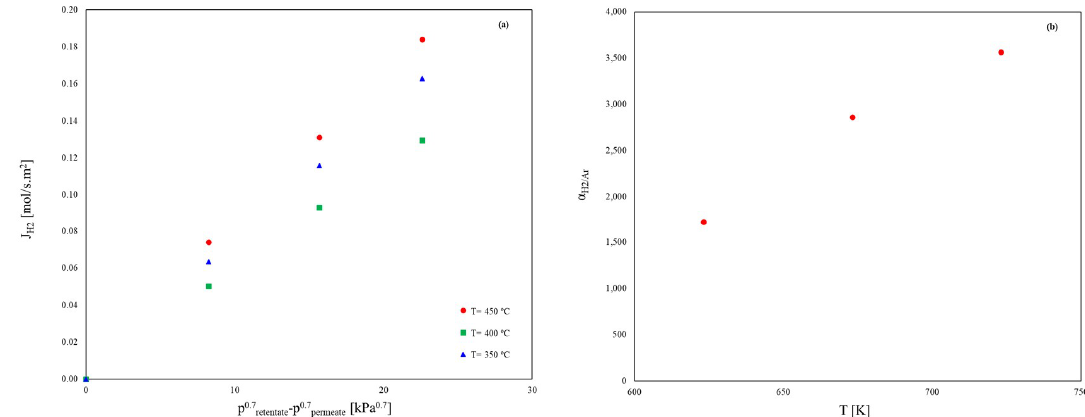
Figure 4. Influence of temperature on the ( a ) permeating flux of H 2 ( b ) ideal selectivity of H 2 to Ar.